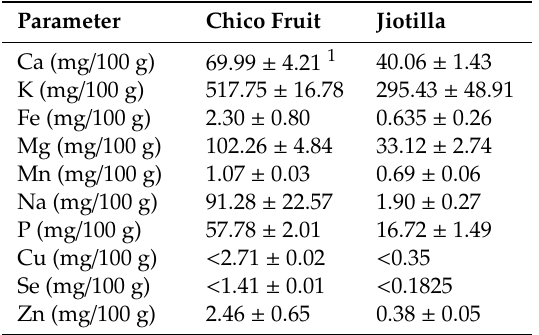
Table 4. Mineral content analysis profile of chico and jiotilla